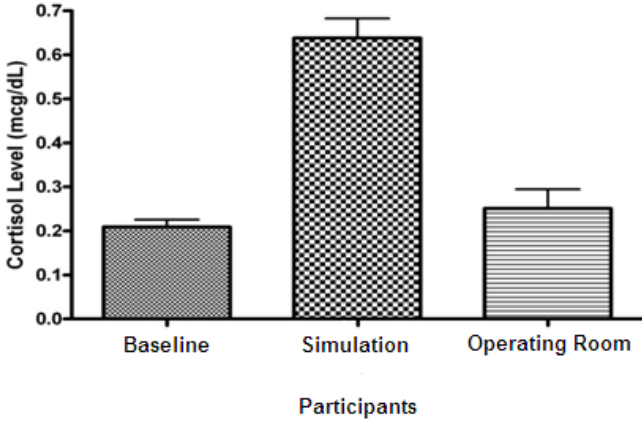
FIGURE 1 . Mean baseline and simulation cortisol levels.